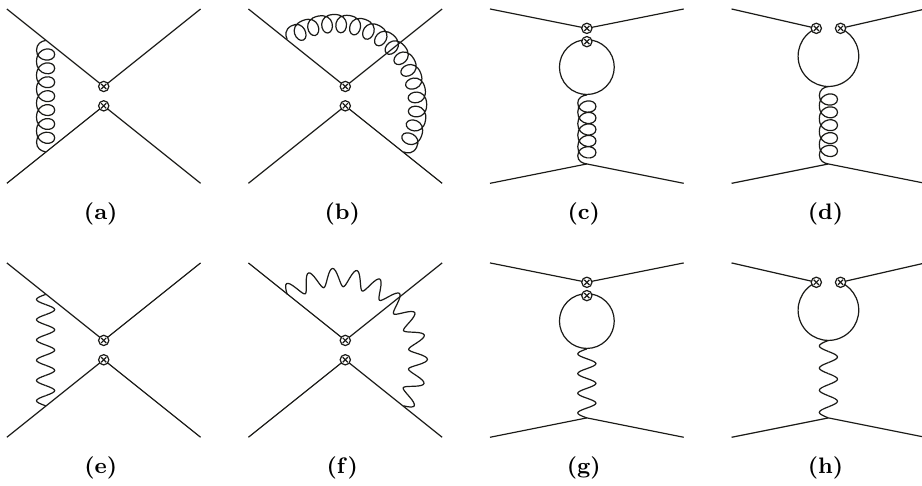
Figure 1. Representative set of one-loop penguin and vertex diagrams needed for the evaluation of the anomalous dimension matrix at order (cid:11) s and (cid:11) em